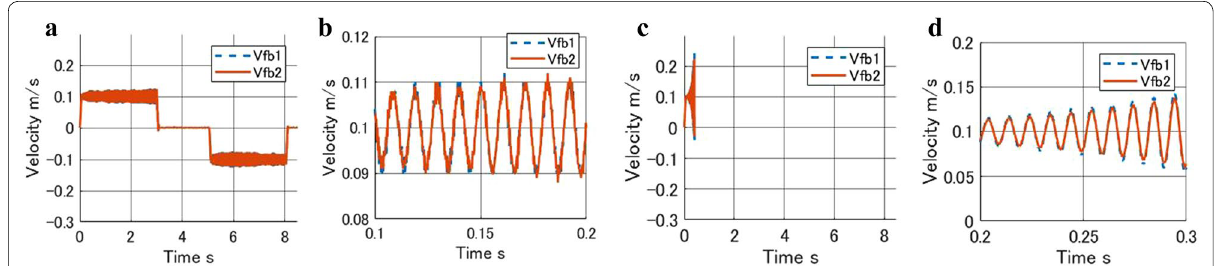
Fig. 14 Comparison of velocity response of simulation and actual experiment in Case 2-2. a Velocity response of actual machine, b velocity response of actual machine (enlarged), c velocity response of simulation, d velocity response of simulation